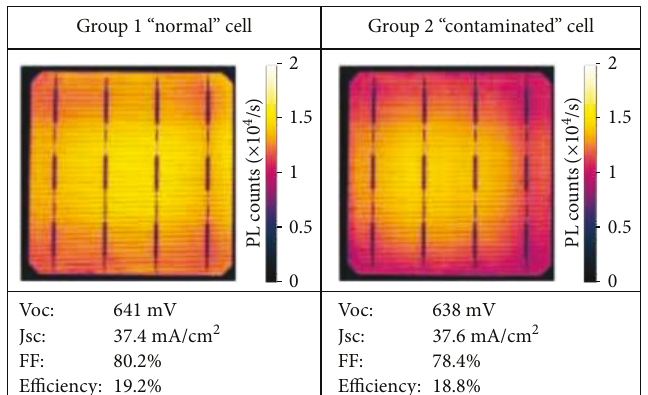
Figure 3: PL image and IV characteristics of a group 1 normal solar cell and a group 2 contaminated solar cell as